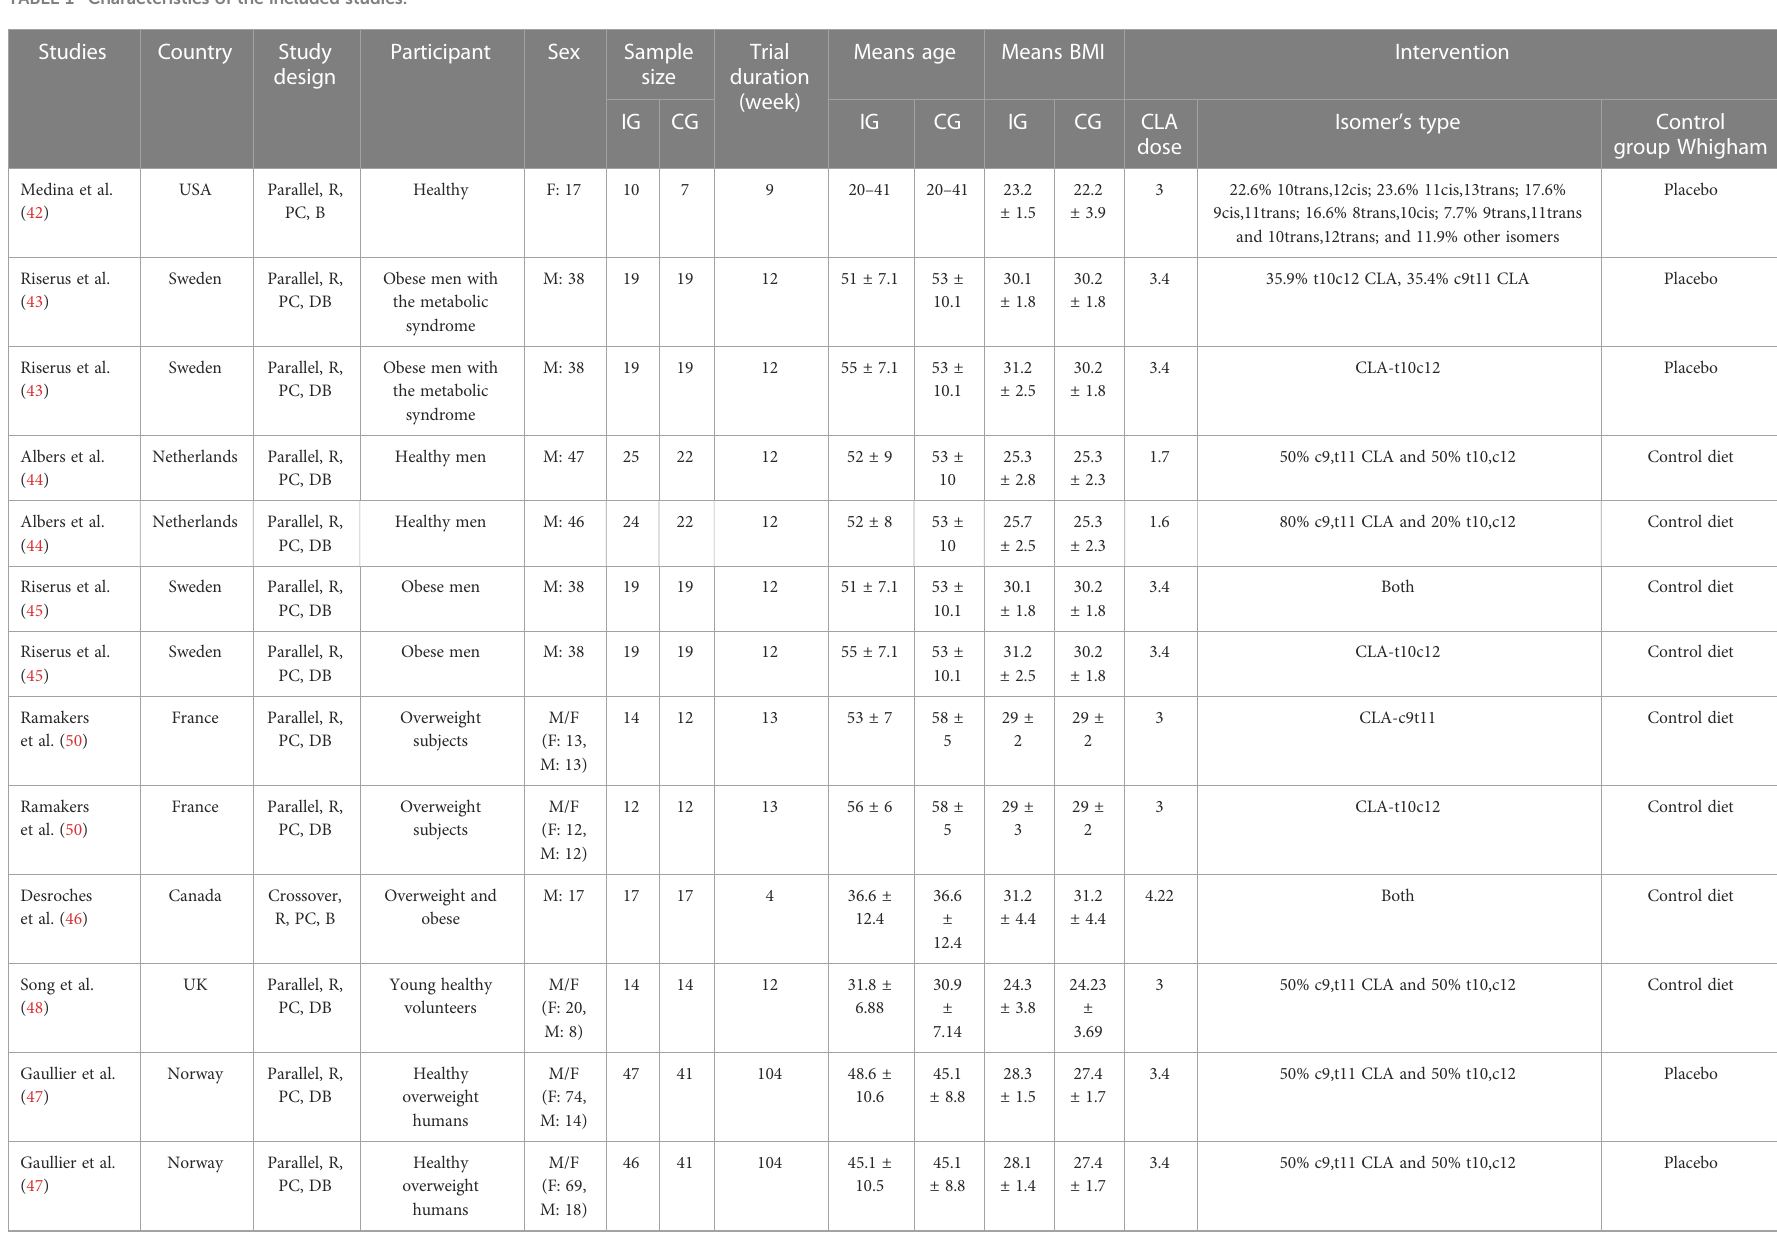
TABLE 1 Characteristics of the included